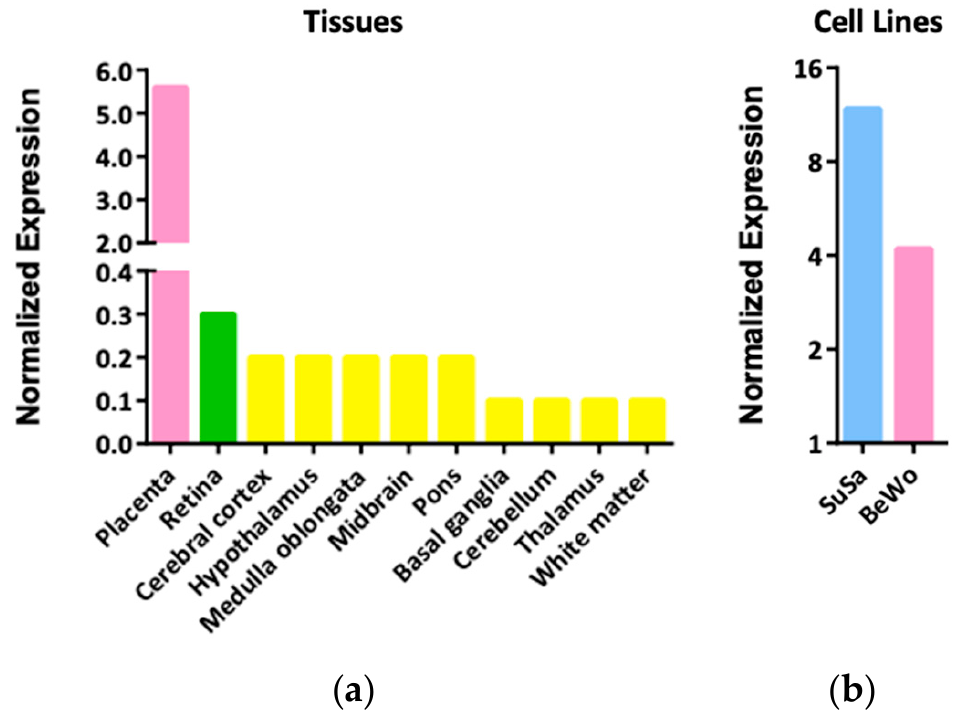
Figure 3. The normalized expression of LGALS16 mRNA in human tissues and cells from HPA da- tasets. ( a ) LGALS16 -positive cases out of 55 tissue types; ( b ) LGALS16 -positive cases out of 69 cell lines. The data were retrieved on 28 November